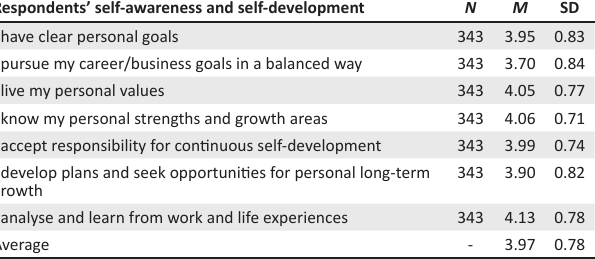
TABLE 5: Respondents’ self-awareness and